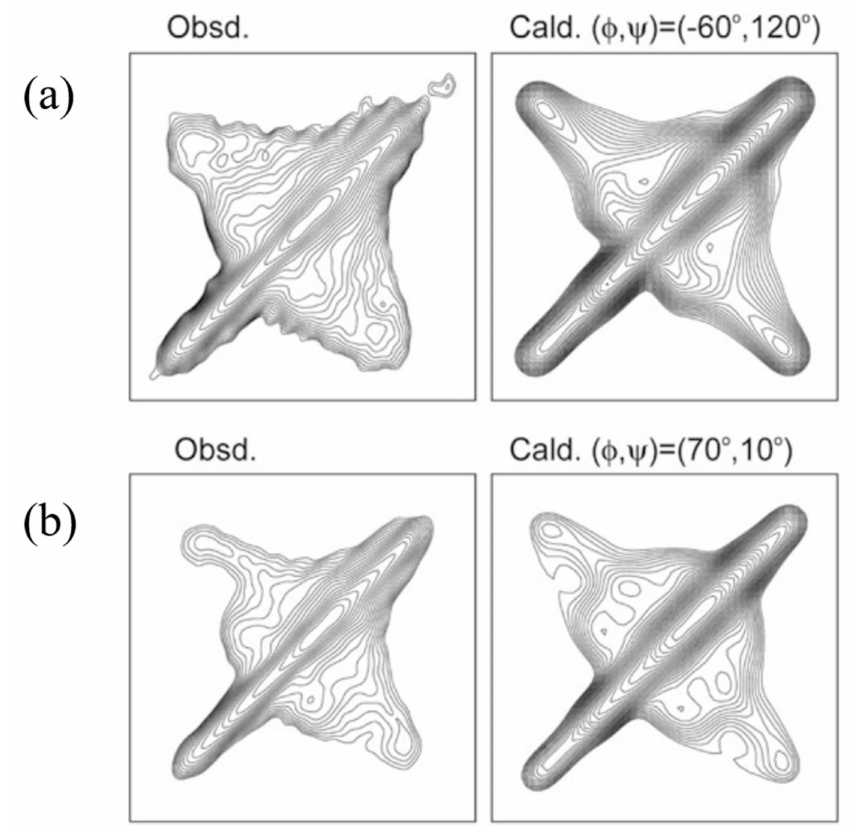
Figure 4. Observed 2D spin-diffusion NMR spectra of ( a ) (AG) 6 A[1- 13 C]G 14 [1- 13 C]A 15 G(AG) 7 and ψ ) of Ala 15 and Gly 16 residues, respectively. The calculated spectra are assuming the torsion angles of Ala 15 ( φ , ψ ) = ( − 60 ◦ , 120 ◦ ) and Gly 16 ( φ , ψ ) = (70 ◦ , 10 ◦ ) were also shown for comparison [22]. Reprinted with permission from ref.